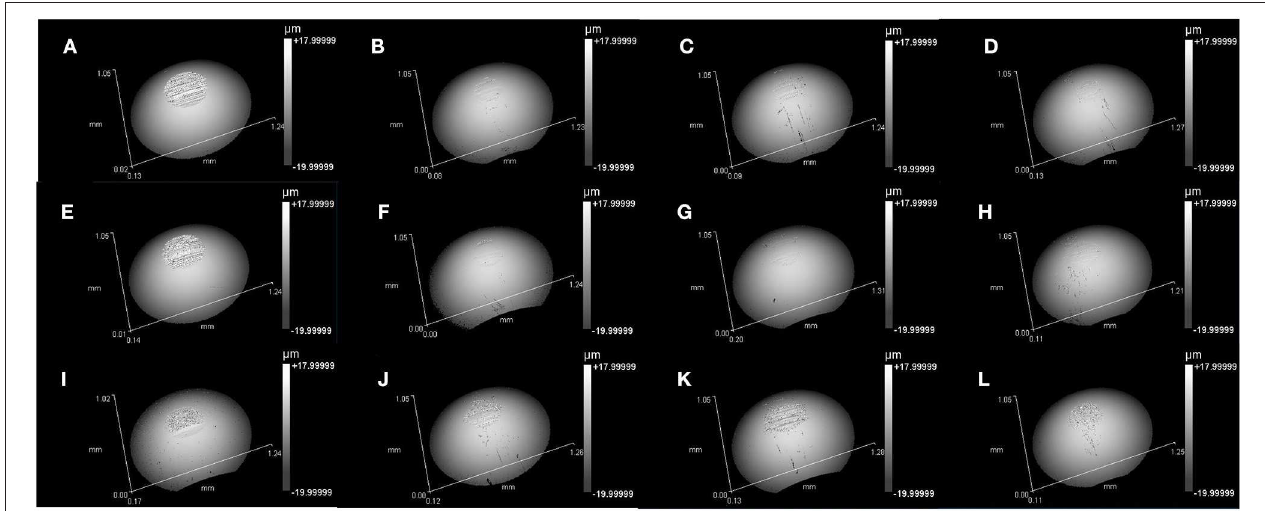
FIGURE 5 | 3D microscopic images of wear tracks on ball surfaces: (A) steel disc lubricated with L-[CH][Pro]-1.5GPa, (B) Tribobond 40 DLC lubricated with L-[CH][Pro]-1.5GPa, (C) Tribobond 43 DLC lubricated with L-[CH][Pro]-1.5GPa, (D) Tribobond 44 DLC lubricated with L-[CH][Pro]-1.5GPa, (E) steel disc lubricated with L-[CH][Pro]-2.0GPa, (F) Tribobond 40 DLC lubricated with L-[CH][Pro]-2.0GPa, (G) Tribobond 43 DLC lubricated with L-[CH][Pro]-2.0GPa, (H) Tribobond 44 DLC lubricated with L-[CH][Pro]-2.0GPa, (I) steel disc lubricated with GW/S5-2.0GPa, (J) Tribobond 40 DLC lubricated with GW/S5-2.0GPa, (K) Tribobond 43 DLC lubricated with GW/S5-2.0GPa, (L) Tribobond 44 DLC lubricated with GW/S5-2.0GPa.